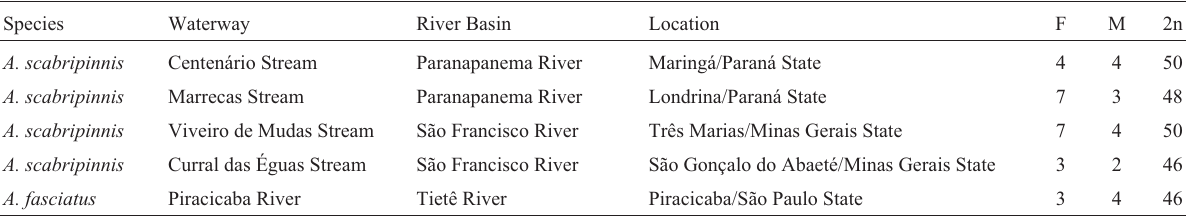
Table 1 - Collection sites and number of specimens of Astyanax